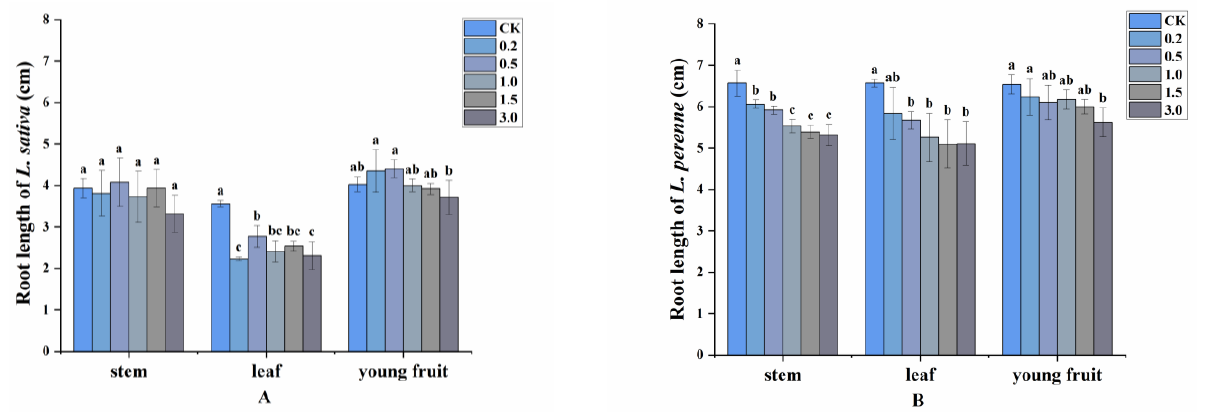
Plants 2022 , 11 , x FOR PEER REVIEW Figure 3. Allelopathic effects of volatile oils from A. villosum on the root length of ( A ): L. sativa and ( B ): L. perenne . Each value is the mean of three replicates ± SD ( n = 30). Means with different lowercase letters indicate significant differences at p < 0.05 level according to ANOVA and Fisher’s LSD test.